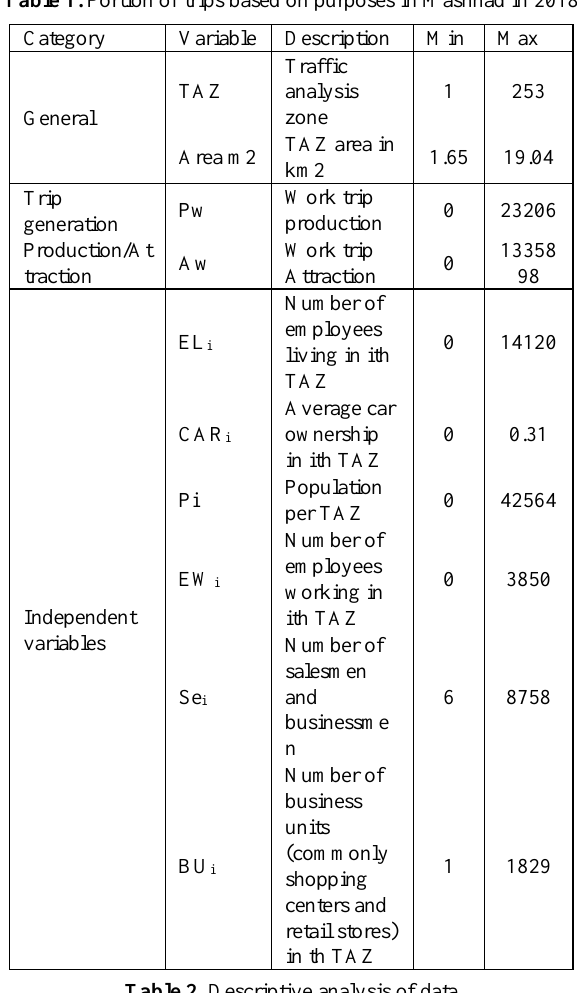
Table 2. Descriptive analysis of